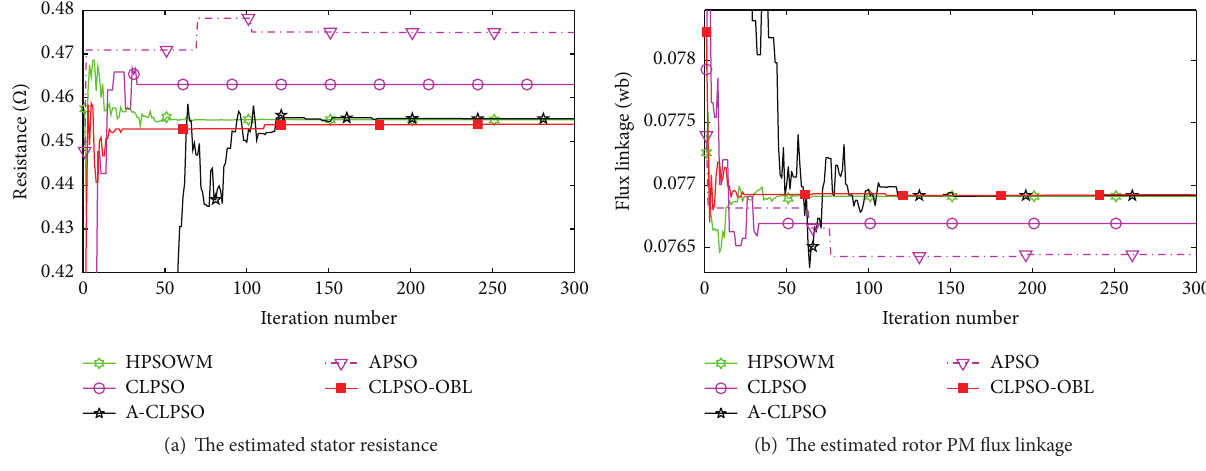
Figure 7: Identified parameters under temperature variation (with heating for